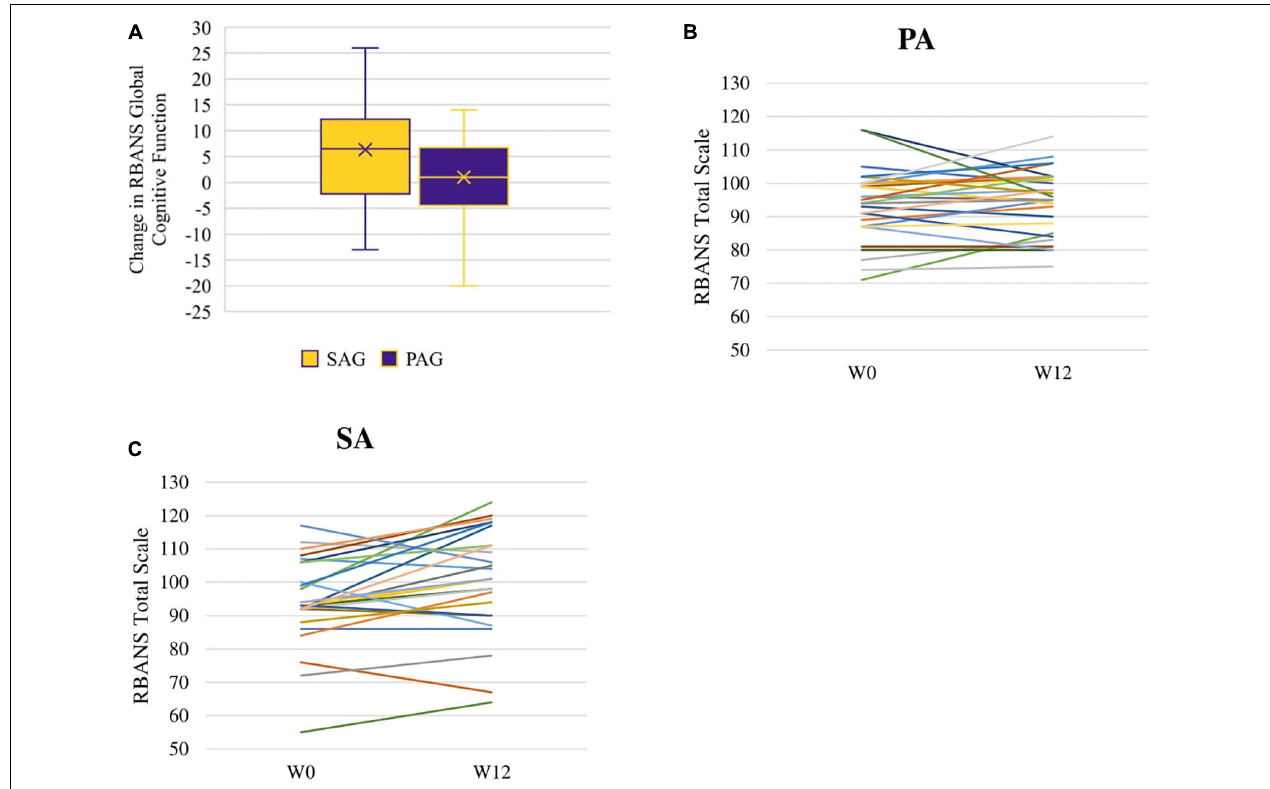
FIGURE 2 | RBANS total scale change between week 0 (W0) and week 12 (W12): distribution of change within SAG and PAG groups (A) and spaghetti plots of individual changes among PA (B) and SA (C) participants.